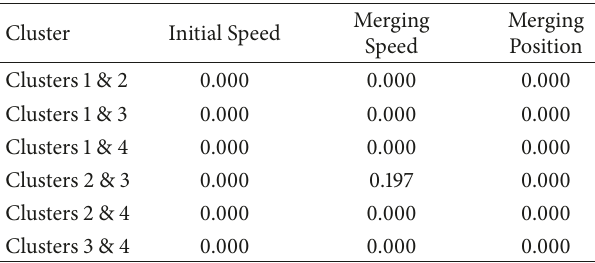
Table 2: Mann–Whitney 𝑈 test results of merging